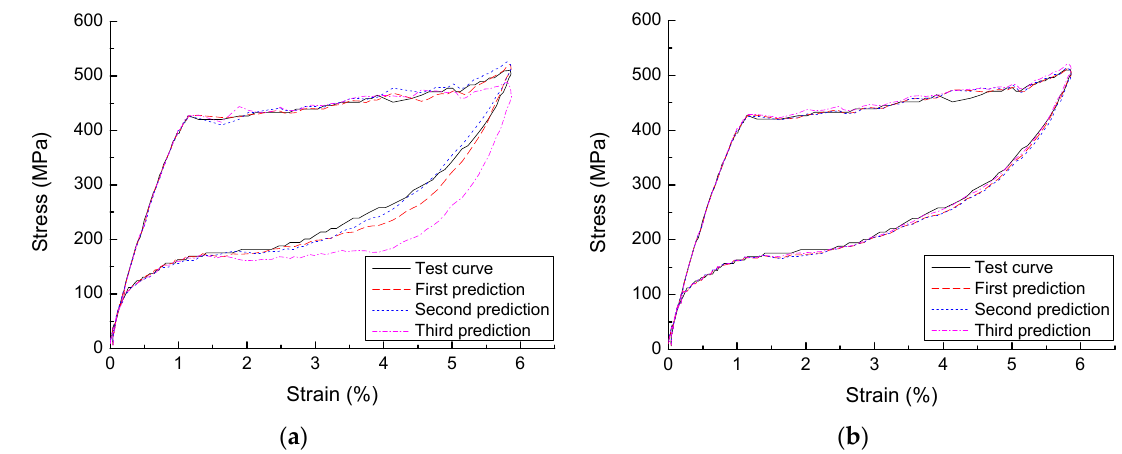
Figure 9. Comparison of BP network prediction curve and test curve ( a ) unoptimized BP network and ( b ) optimized BP network.